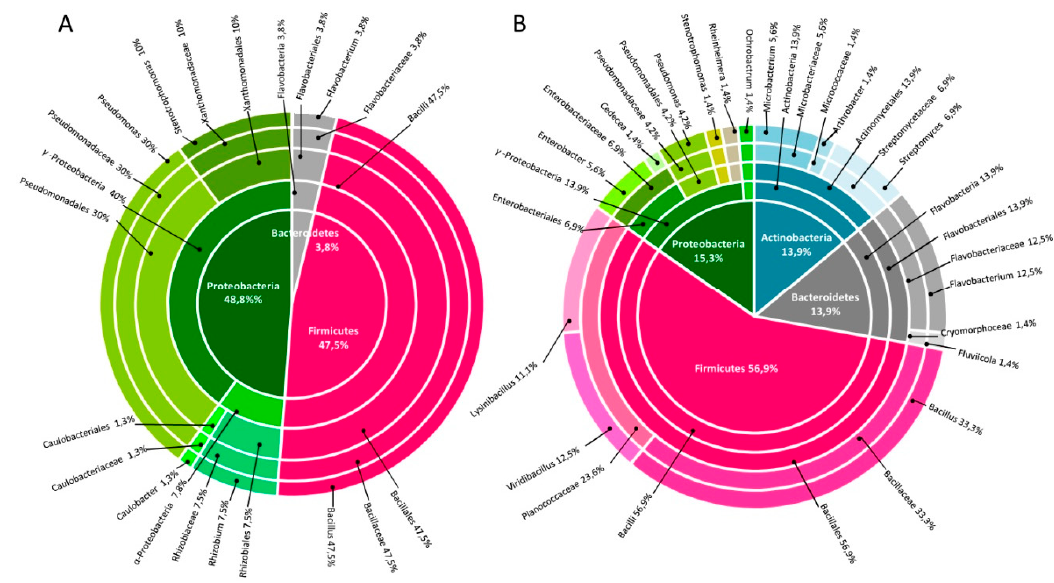
Figure 2. Taxonomic distribution of 16S rRNA sequences of culturable endophytic ( A ) and rhizospheric ( B ) bacteria isolated from P. australis plants. The inner pie graph shows the strain taxonomic identification according to phylum and each outer ring represents their identity at the class, order, family and genus level.